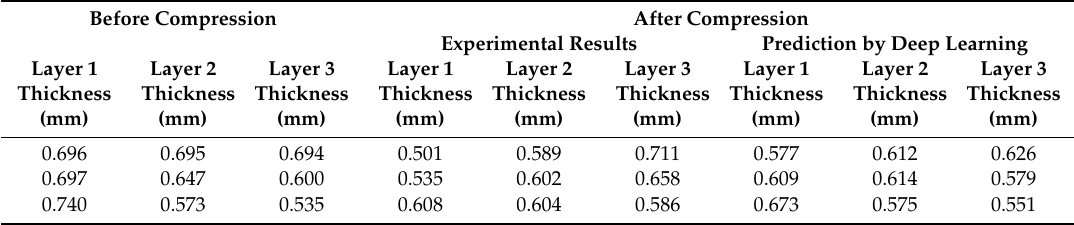
Table 2. Experimentally obtained thickness [22] for three-layer compression and deep learning prediction based on training using the two-layer compression data shown in Table 1.